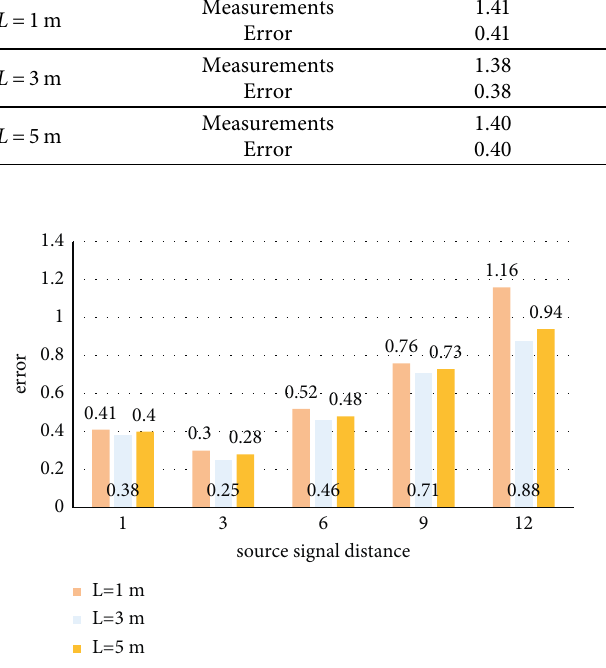
Figure 2: Localization error based on target